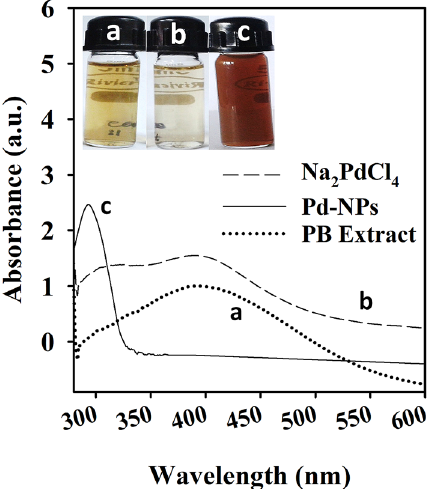
Figure 2. UV–Visible spectroscopic analysis of P. boryana aqueous extract ( A ), Na 2 PdCl 4 ( B ), and Pd-NPs. Glass vials in inset represent the color change of PB-extract and Na 2 PdCl 4 mixture after Pd-NPs synthesis.